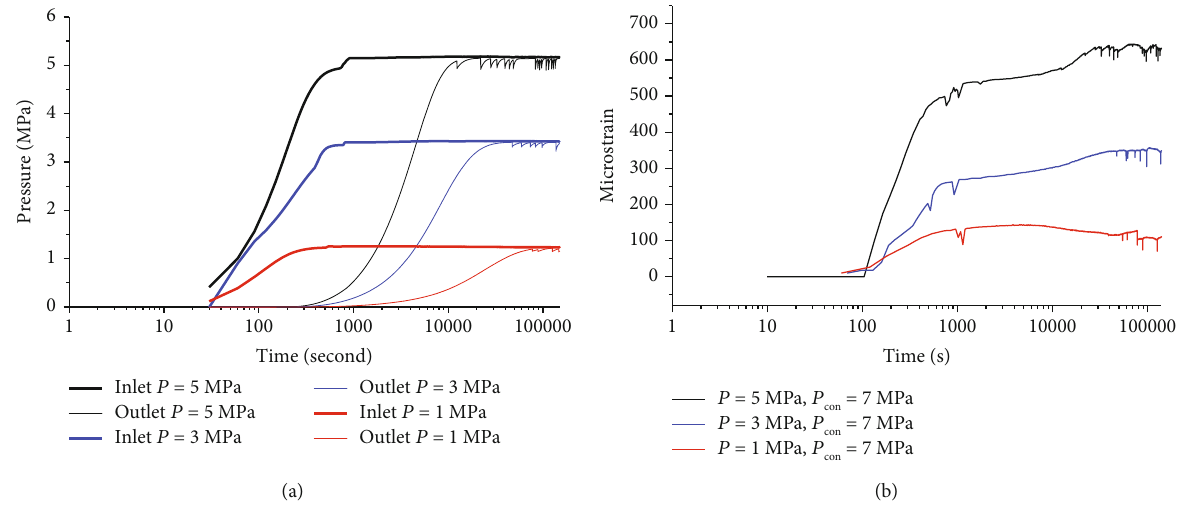
Figure 4: Experimental results under constant con fi ning stress. (a) Gas pressure changes of upstream reservoir/downstream reservoir; (b) circumference strain of the coal